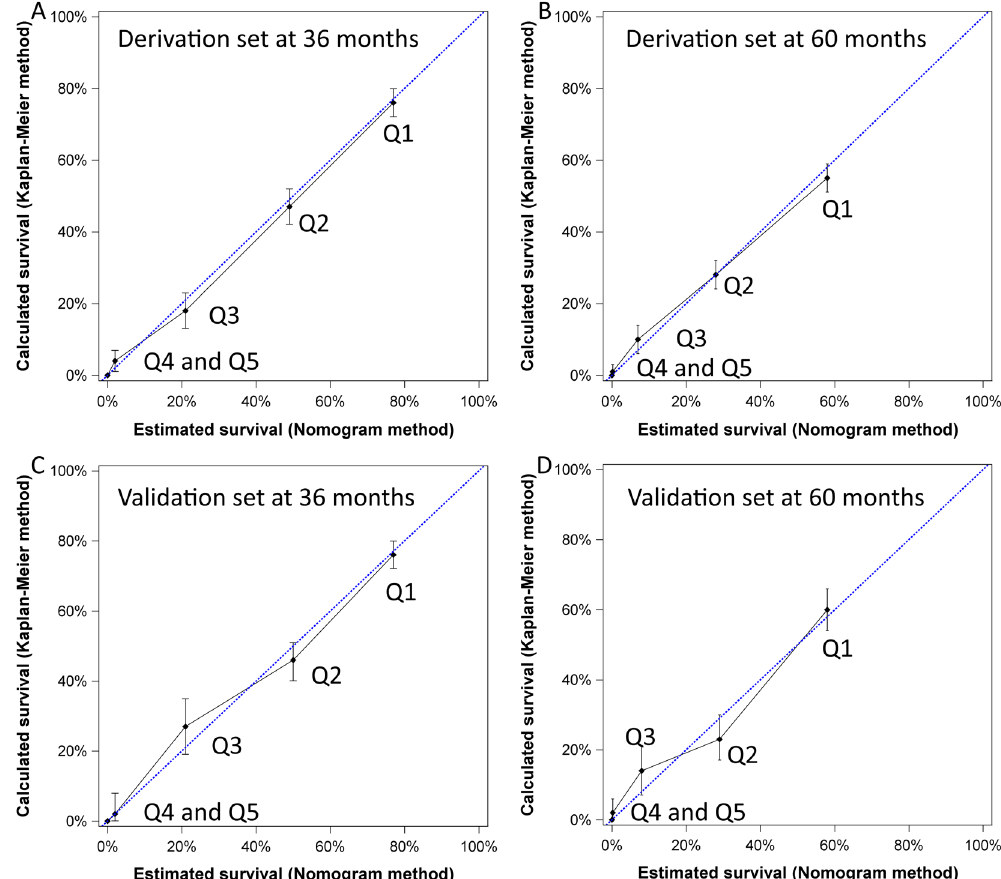
Figure 4. The calibration plots of the nomogram of derivation and validation sets for 3- and 5-year survival predictions. The X-axis represents the nomogram-predicted survival and the Y-axis shows the mean survival and 95% confidence interval calculated by the Kaplan-Meier method. Patients were divided into quintiles (Q) to evaluate the accuracy of nomogram (Q1: ≤ 6, Q2: 6.1 to 12, Q3: 12.1 to 18, Q4: 18.1 to 24, Q5: > 24). For patients from both derivation and validation sets, the calibration lines fit along with the 45-degree reference for both 3- and 5-year survival predictions except for patients nomogram point more than